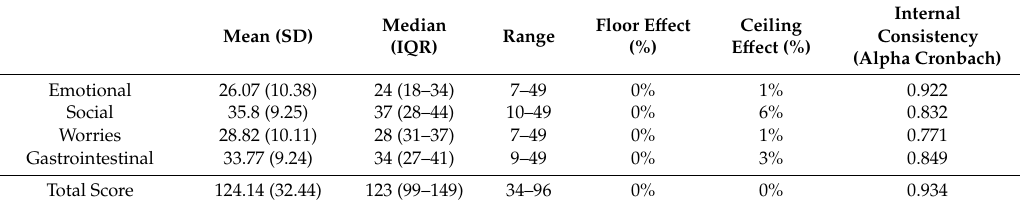
Table 1. Description of internal consistency of the Argentinian